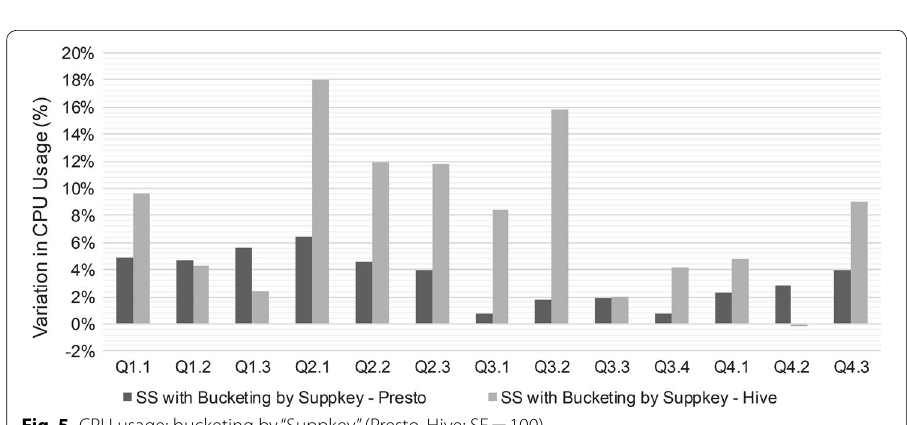
Fig. 5 CPU usage: bucketing by “Suppkey” (Presto, Hive; SF